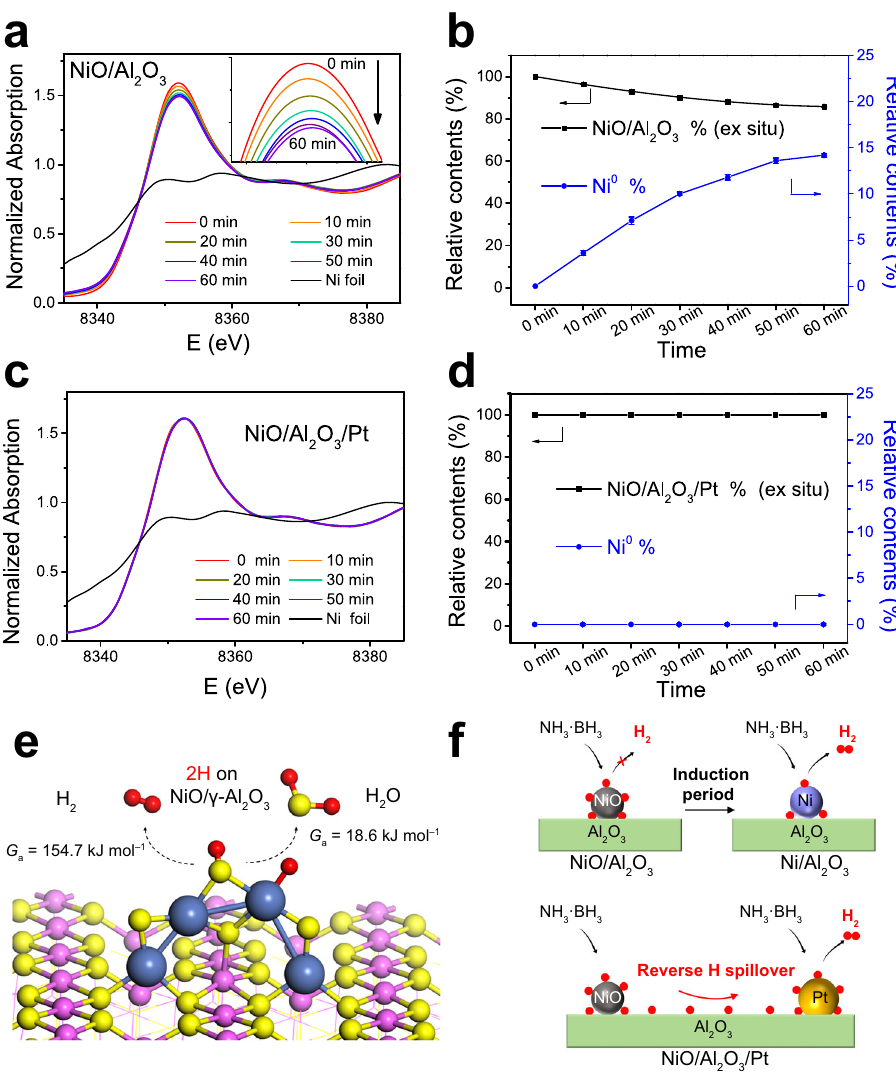
Fig. 3 In situ XANES spectra for the catalysts and proposed mechanisms. In situ Ni K-edge XANES spectra for a NiO/Al 2 O 3 and c NiO/Al 2 O 3 /Pt, and the percent of metallic Ni 0 in the b NiO/Al 2 O 3 and d NiO/Al 2 O 3 /Pt catalysts versus time during the reaction. The inset in a shows the expanded sections for the white line peaks. For each sample, the in situ spectrum is fi tted by a linear combination of the ex situ spectrum and the spectrum for Ni foil. Error bars represent the fi tting errors from XANES. e The free energy barriers ( G a ) at room temperature (298.15 K) for the formation and desorption of H 2 (left arrow) and water (right arrow) on NiO/ γ − Al 2 O 3 (100) computed by the DFT method. Colour legend: Al, pink; O, yellow; Ni, cyan; and H, red. f Proposed reaction mechanisms for NiO/Al 2 O 3 and NiO/Al 2 O 3 /Pt in the H 2 generation reaction. During the induction period for NiO/Al 2 O 3 , the H species generated at NiO sites are consumed to reduce the oxide catalyst to metallic Ni 0 . For NiO/Al 2 O 3 /Pt, the H species generated at NiO sites reversely spill across the Al 2 O 3 support to Pt sites, where they can combine into H 2 and